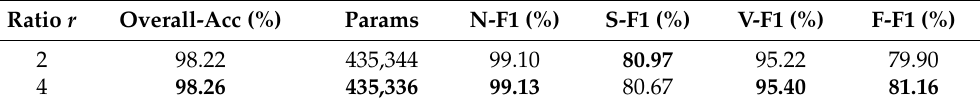
Table 5. Effect at different reduction